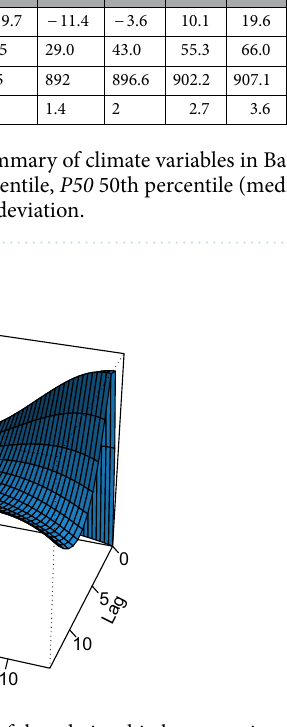
Figure 1. 3-d diagrams of the relationship between air temperature and the hospital admission of adult CAP